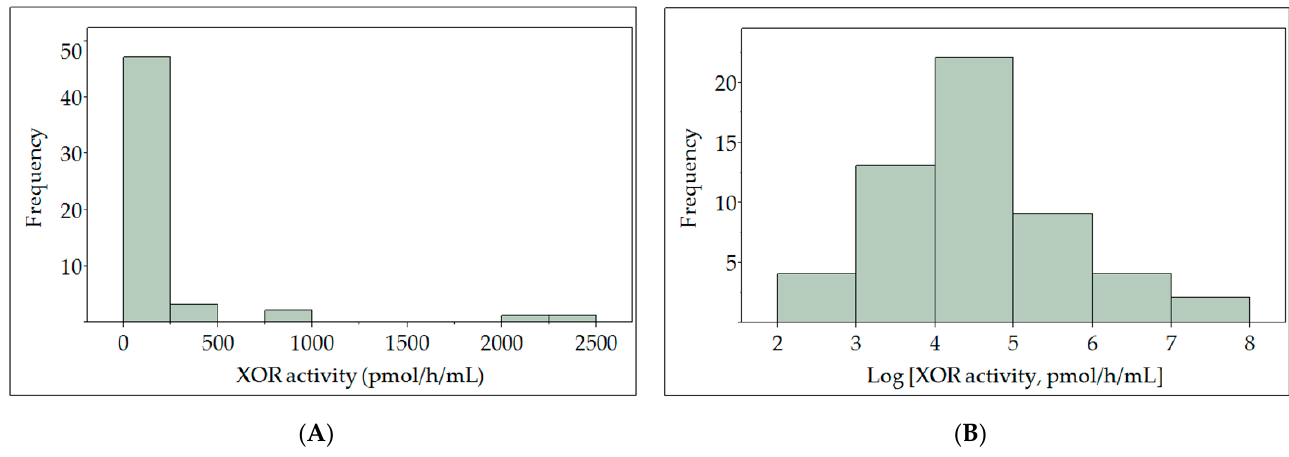
Figure 1. Distribution of plasma XOR activity ( A ) with logarithmically transformed data ( B ) displayed as a histogram.